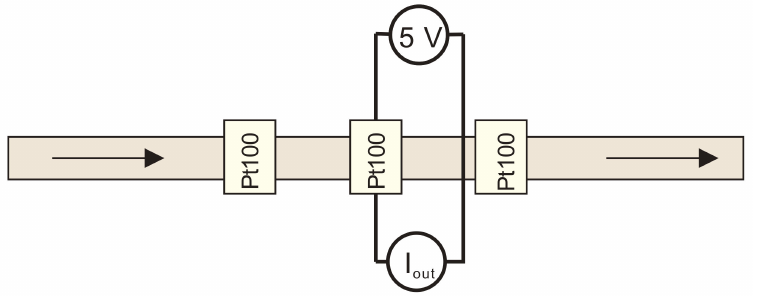
Figure 15. A wiring diagram of the thermal mass flowmeter in a heater/sensor